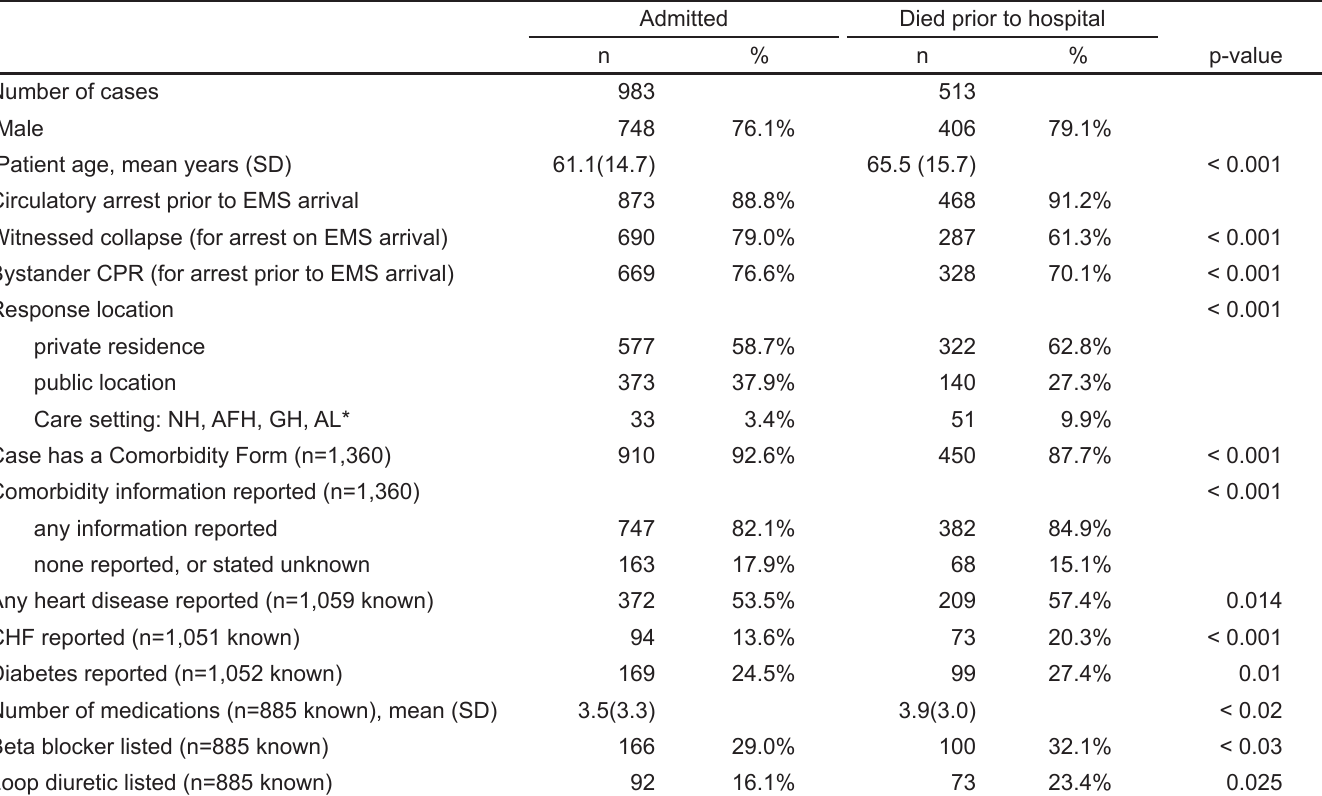
Table 1. Case characteristics by status of patients admitted with non-traumatic cardiac arrest , n = 1,496.